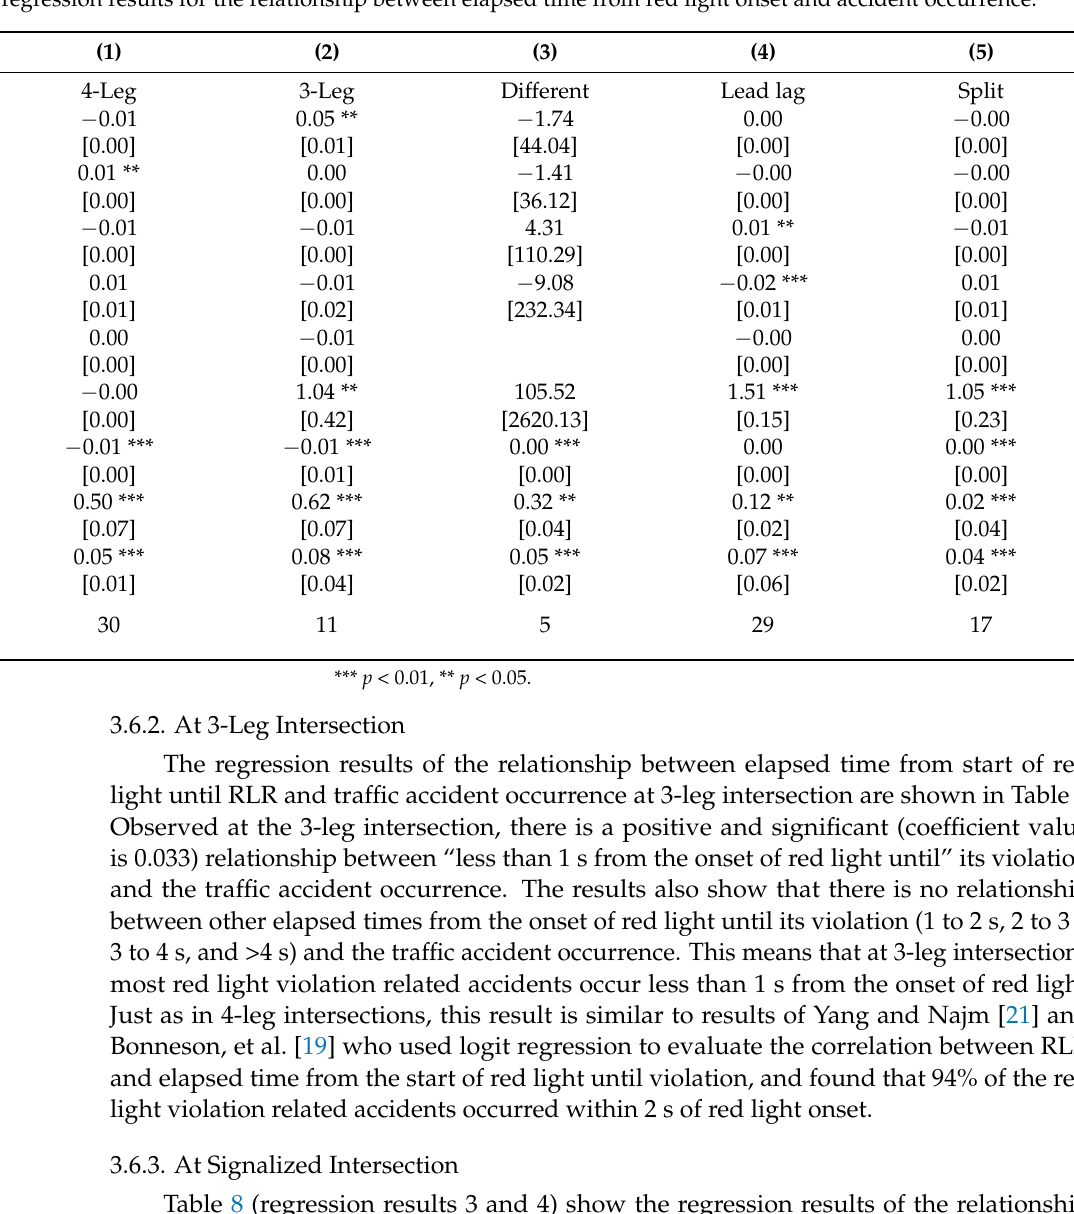
Table 8. Poisson regression results for the relationship between elapsed time from red light onset and accident